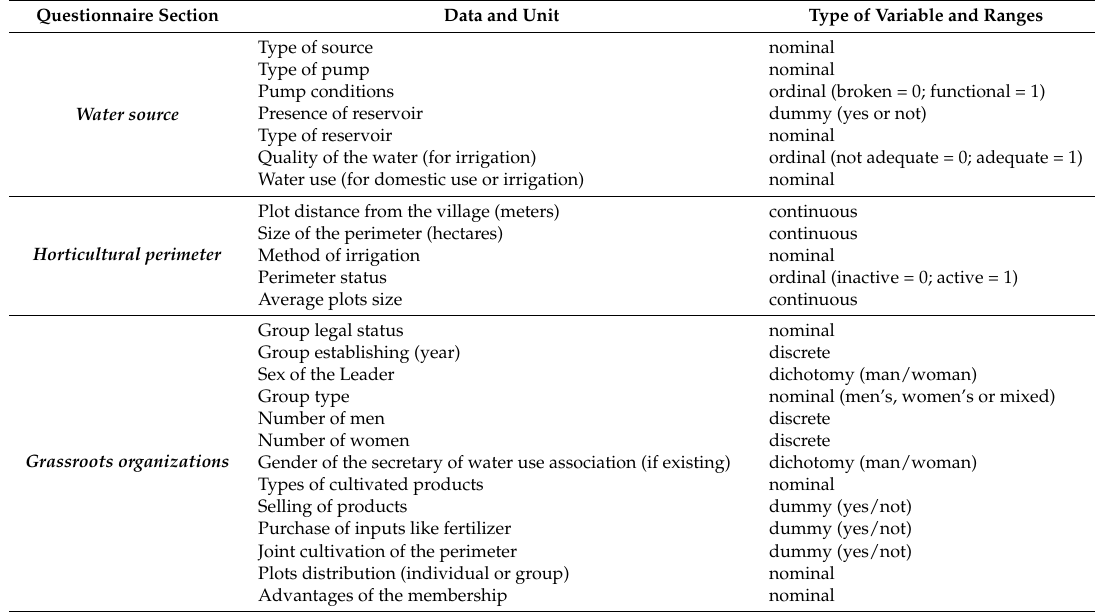
Table 1. The collected data.